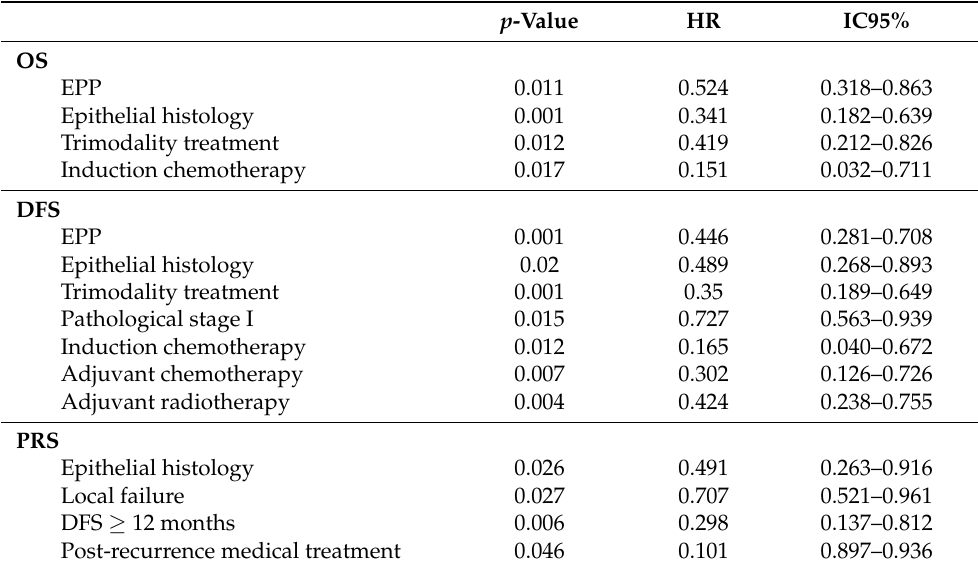
Table 3. Predictors of better survival outcomes at multivariate Cox-regression